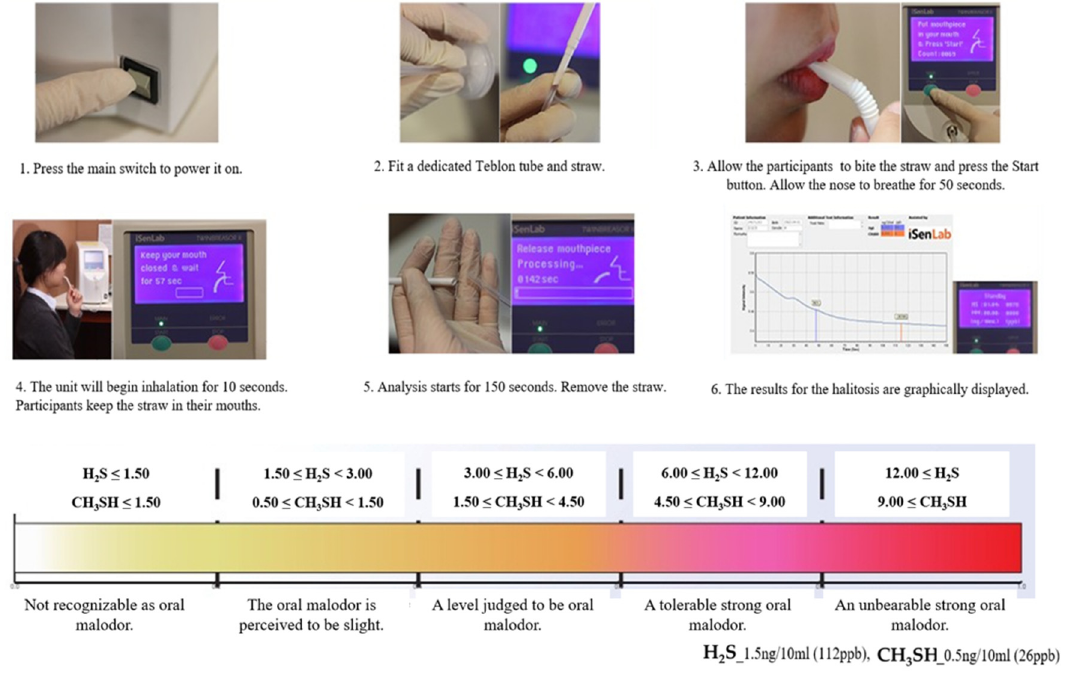
Figure 1. Oral malodor measurement method and evaluation method using Twin Breasor